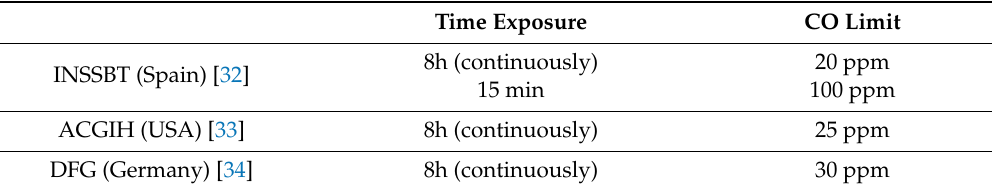
Table 4. Occupational exposure limits